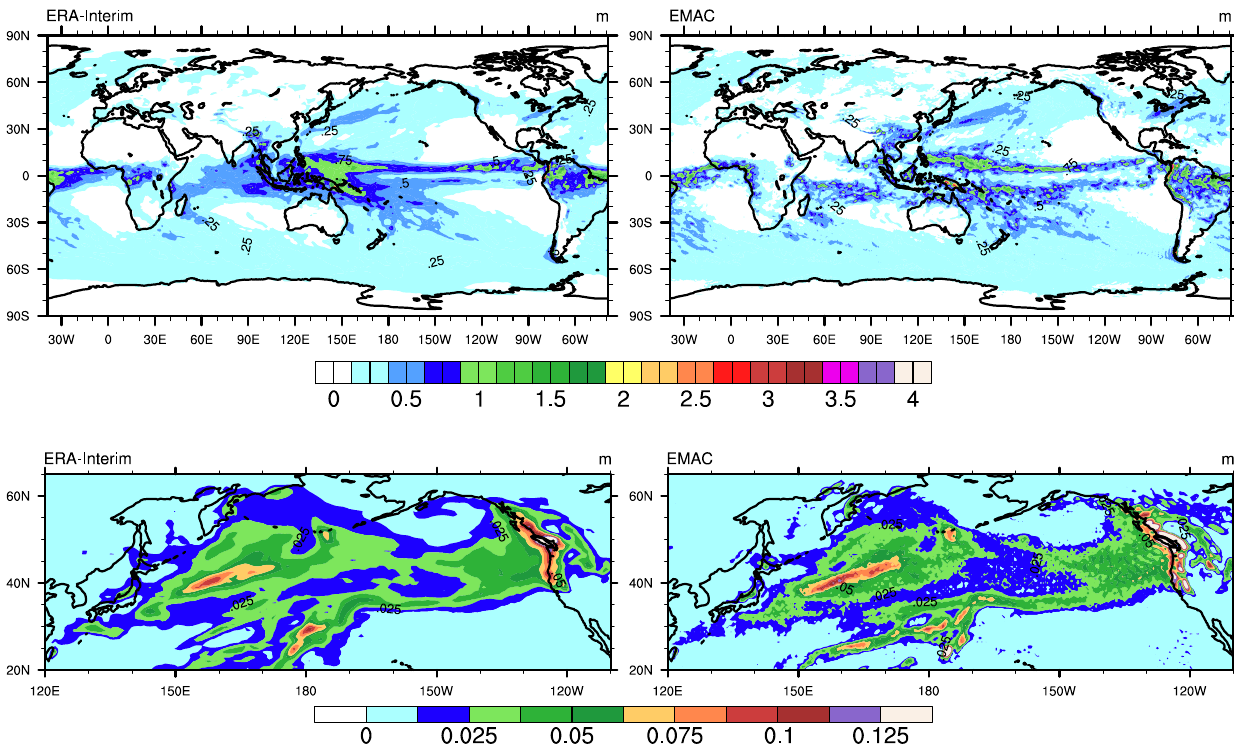
Fig. 1. Time integrated precipitation (in m) patterns over the period 11 March–31 May 2011 computed with the EMAC model (upper right) compared to the ERA-Interim data (upper left). The lower panels show the precipitation during the first week after the accident (11–18 March 2011).